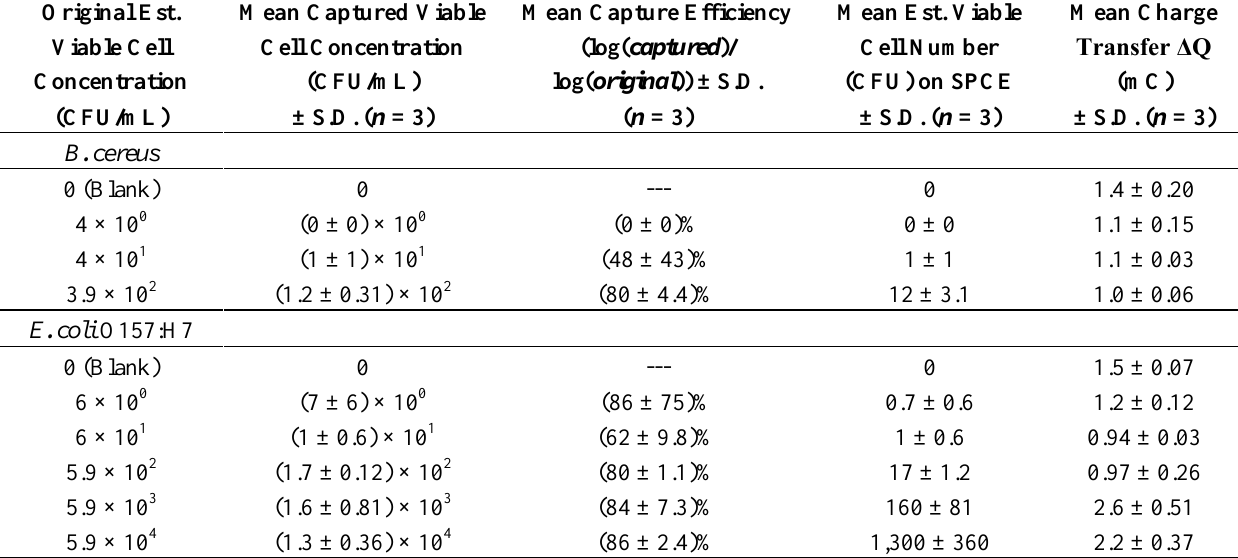
Table 1. Capture of B. cereus and E. coli O157:H7 cells by immuno-c/sNPs. Original